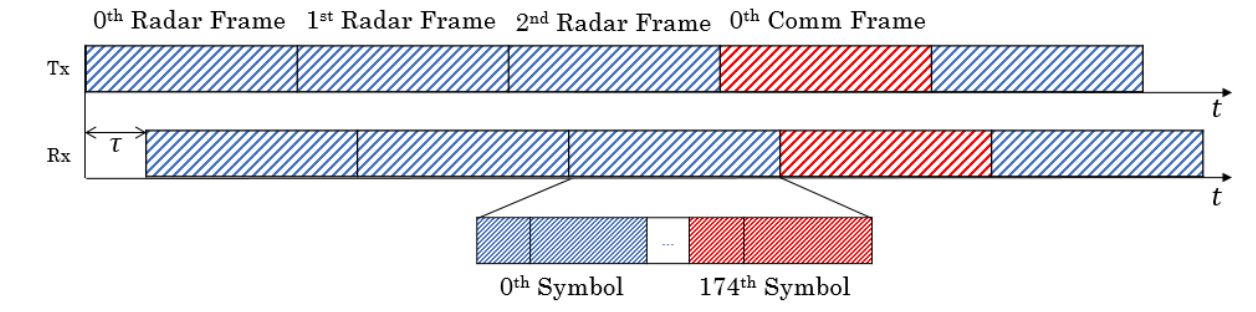
Figure 1. RadCom time-division multiplexing (TDM)